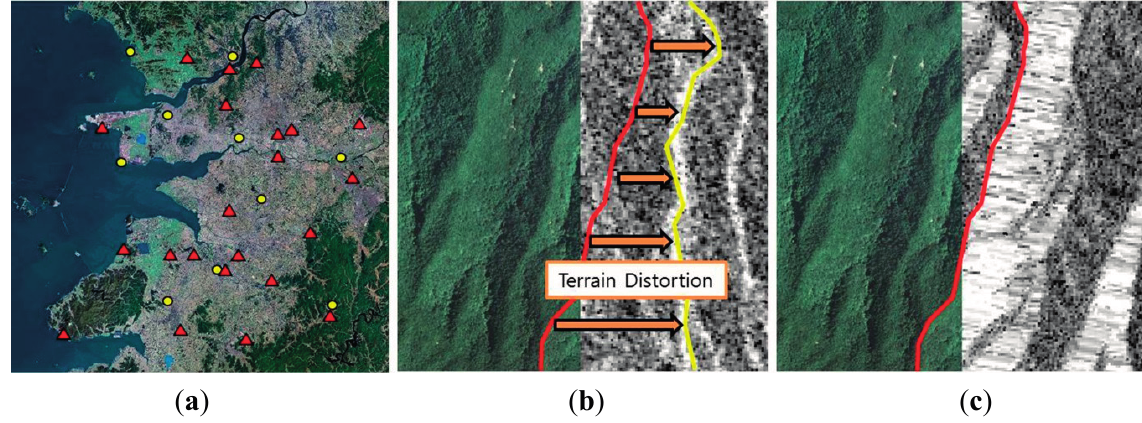
Figure 5. GCPs used for geometric correction and result of geometric and radiometric topographic correction: ( a ) GCPs (yellow: Control point, red: Check point, blue: reference water map); ( b ) orthorectified aerial image and SAR imagery before terrain effect correction (red: an actual ridge, yellow: a ridge represented in SAR imagery, orange: inconsistency of ridge location due to terrain distortion); ( c ) orthorectified aerial image and SAR imagery after terrain effect correction (red: an actual ridge corresponds with a ridge represented in SAR